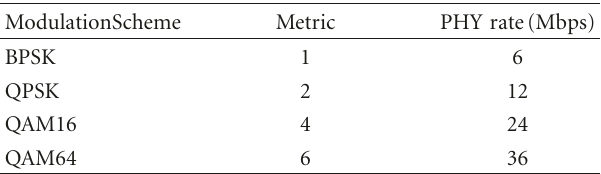
Table 10: Supported data rates in